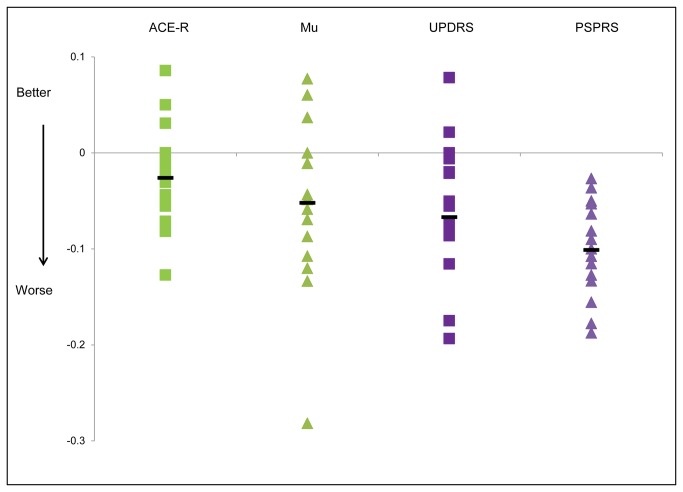
Graph showing annualised and normalised rates of change for different aspects of disease.Green squares are the change in scores for the Addenbrookes Cognitive Examination Revised, green triangles are rates of change for mu (reciprocal latency), purple squares are the change in scores for the Unified Parkinson’s Disease Rating Scale (UPDRS) motor subsection and the purple triangles are the change in scores for the PSP rating scale (PSPRS). The horizontal black lines are the mean rate of change for each test. Values below the x axis represent worsening of patients’ conditions and those above the x axis are improving.